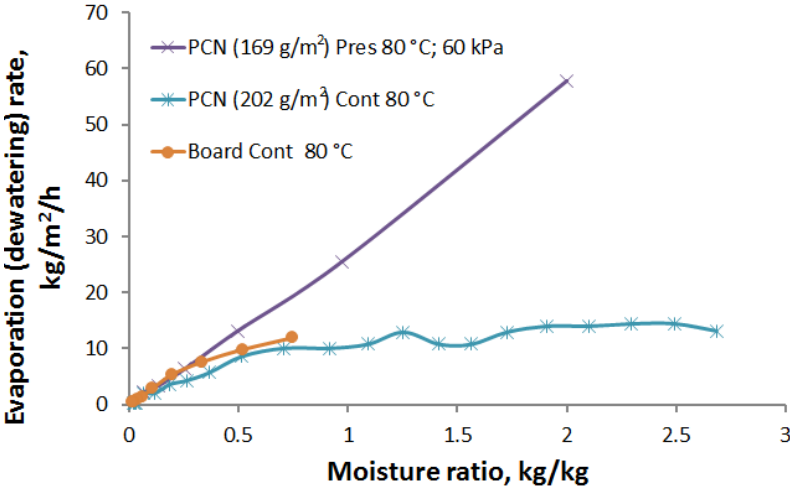
Figure 7. Comparison of the press dewatering rate (pressure 60 kPa, temperature 80 °C) with the evaporation rate in the normal contact drying (equal temperature) for the PCN sheets. The corresponding result for the contact drying of board is shown by the